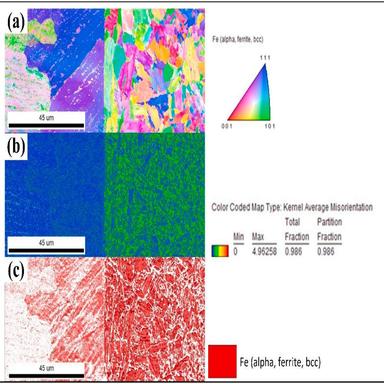
EBSD scan at P91 weld interface: (a) IPF map (b) KAM map (c) phase map.